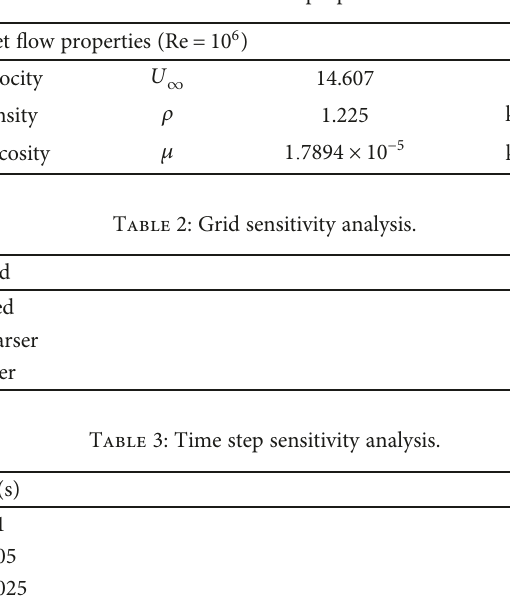
Table 1: Inlet fl ow properties.